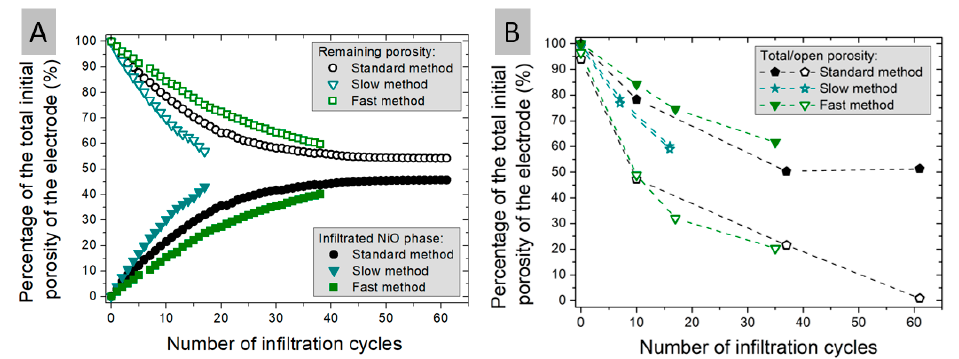
Figure 4. Normalized to 100% porosity curves of ( A ) changes in volume fraction of individual fractions for the sample dried by the three different methods together with ( B ) porosity obtained by fractions for the sample dried by the three di ff erent methods together with ( B ) porosity obtained by Archimedes method. Archimedes